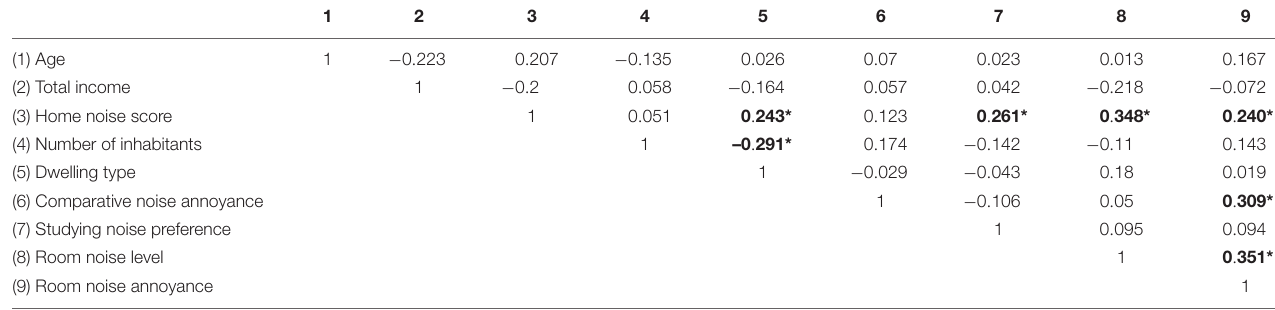
TABLE 3 | Correlations between participant age, home measures, and subjective noise measures.